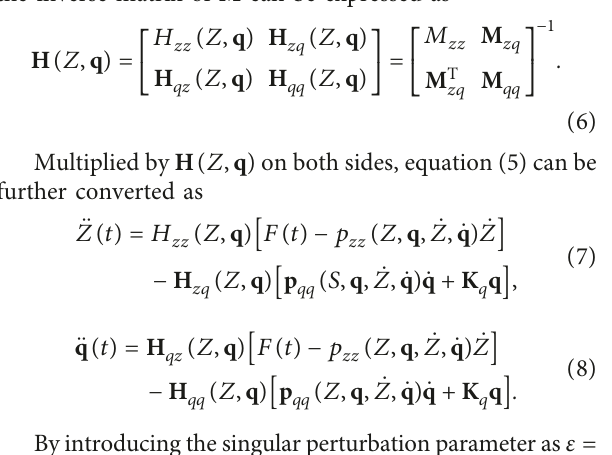
Figure 1: Schematic diagram of the